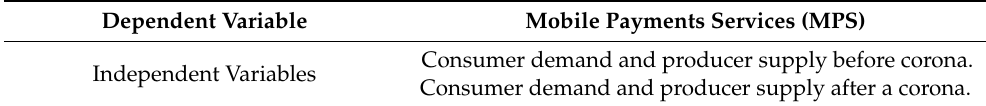
Table 1. Dependent and independent